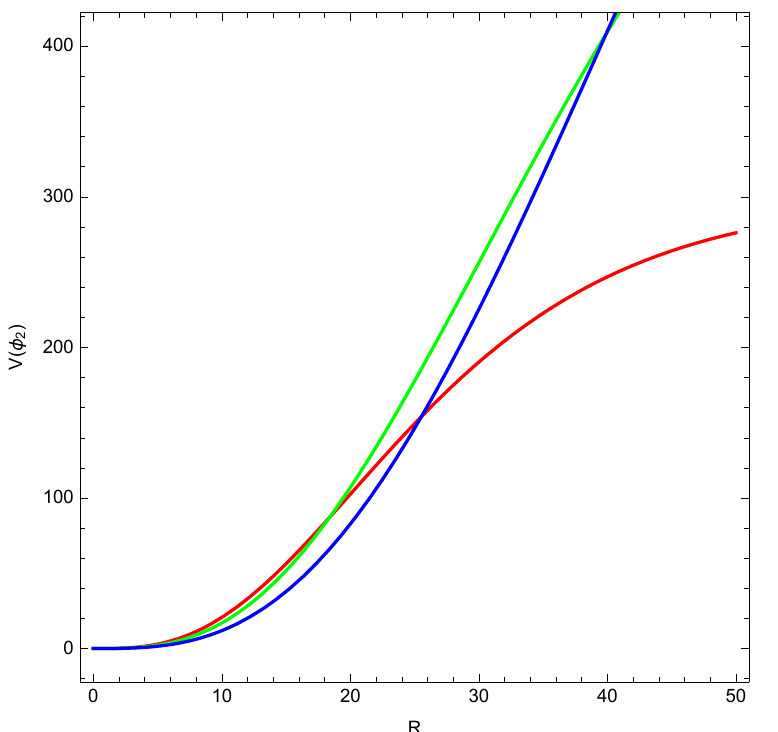
Figure 32. The evolution of V ( φ 2 ) is obtained using Equations (32) and (46). The red, green, and blue lines correspond to small perturbations of R T and µ ,